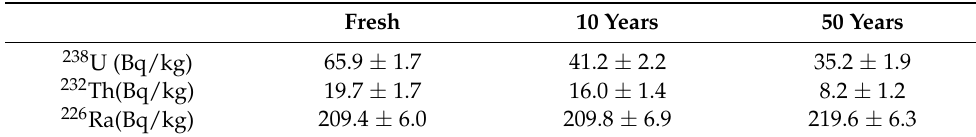
Table 2. Average activities of the principal natural radioelements of PG.